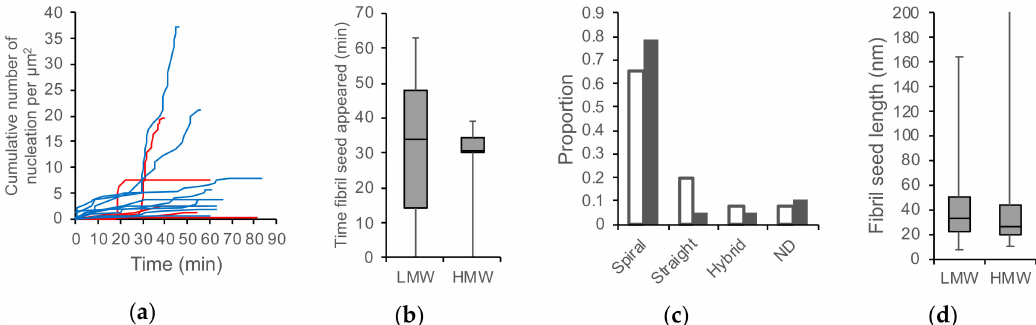
Figure 7. Timing of the fibril appearance in the incubation of LMW and HWW A β 42. ( a ) Time courses of cumulative number of fibrils in the observation area from LMW (blue lines) and HMW (red lines) A β 42 incubation. Di ff erent lines correspond to di ff erent experiments. ( b – d ) The distribution of times at which individual fibril seeds appeared ( b ), the fibril type ( c ), and the length of fibril seeds when they first appeared in the observation area ( d ). The open and closed bars in ( c ) correspond to LMW and HMW incubation, respectively. Reproduced from